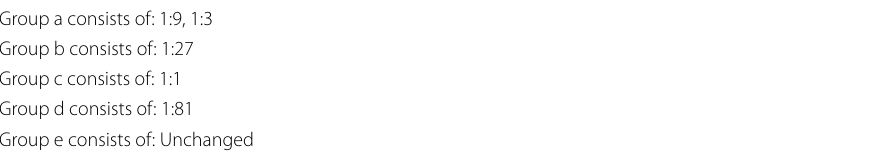
Table 26 HSD test groupings after ANOVA of AUC for the RUS